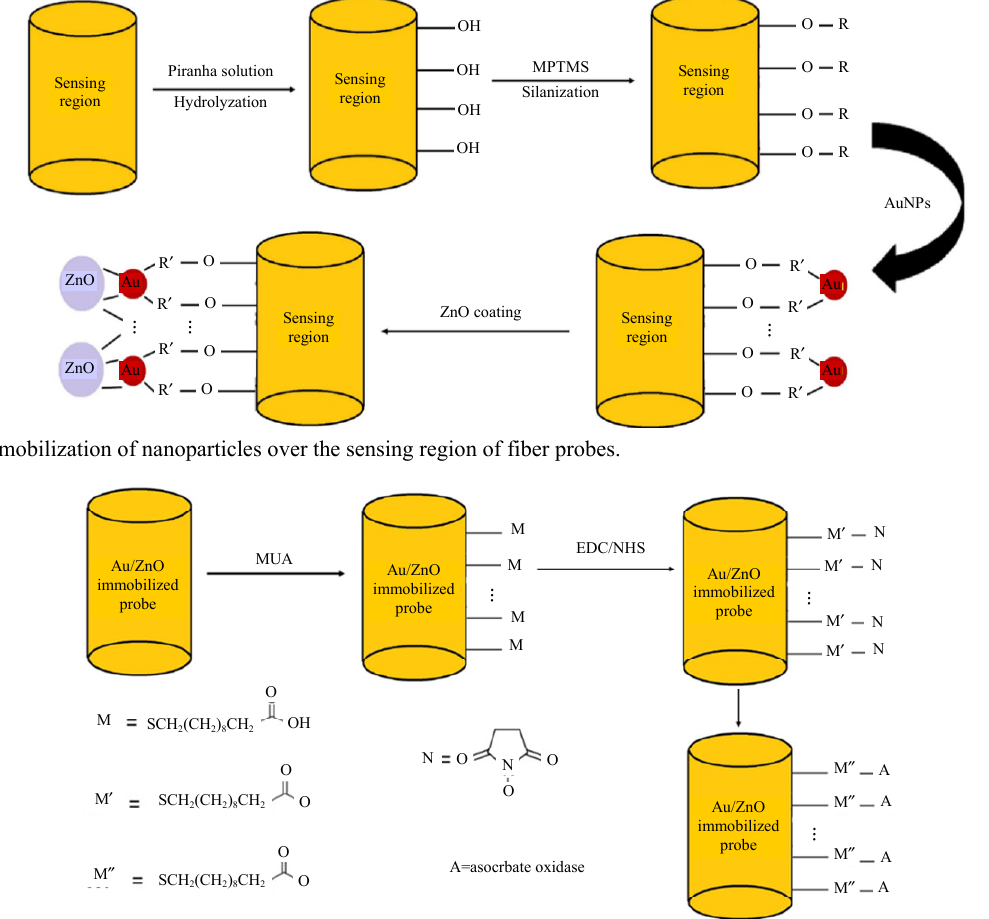
Fig. 3 Functionalization of enzyme over nanoparticles-coated fiber